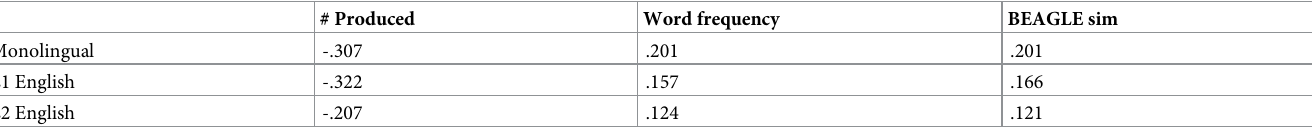
Table 1. Correlations between age and the three psycholinguistic variables for the difference language groups.